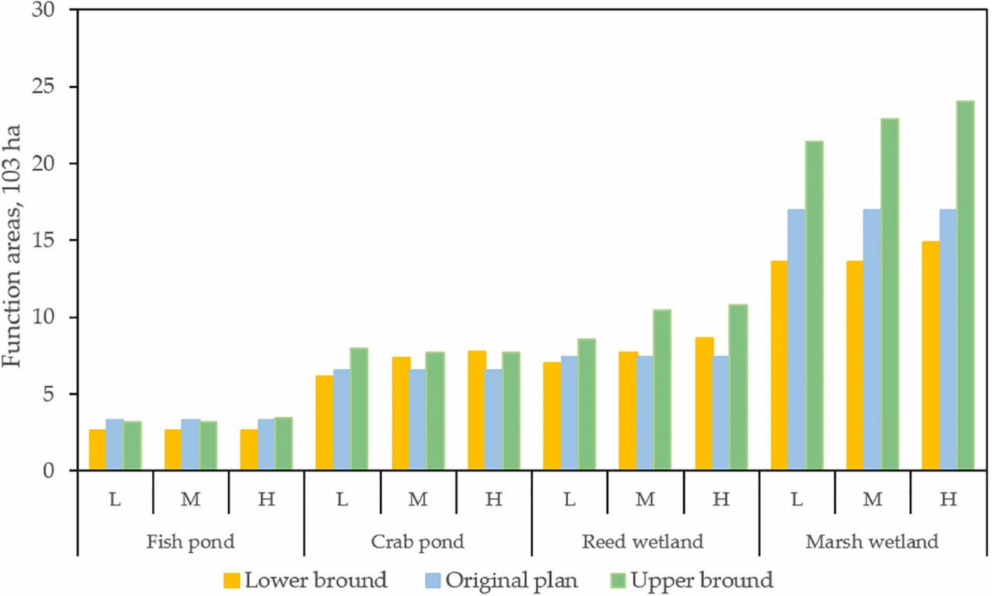
Figure 6. The restored ecological functional areas of the Momoge National Nature Reserve (MNNR) by recommended scheme and optimization schemes under di ff erent flow scenarios of water